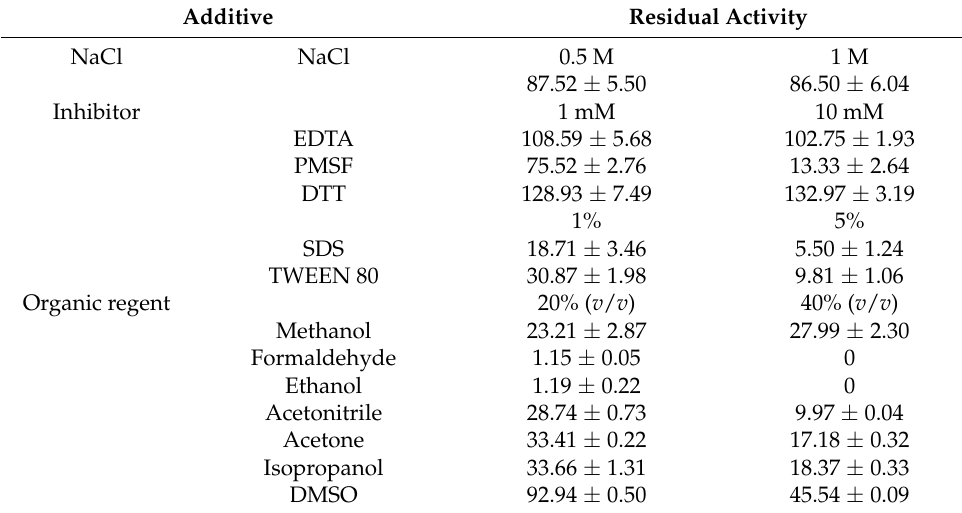
Table 2. Relative activity percentage in the presence of additives.